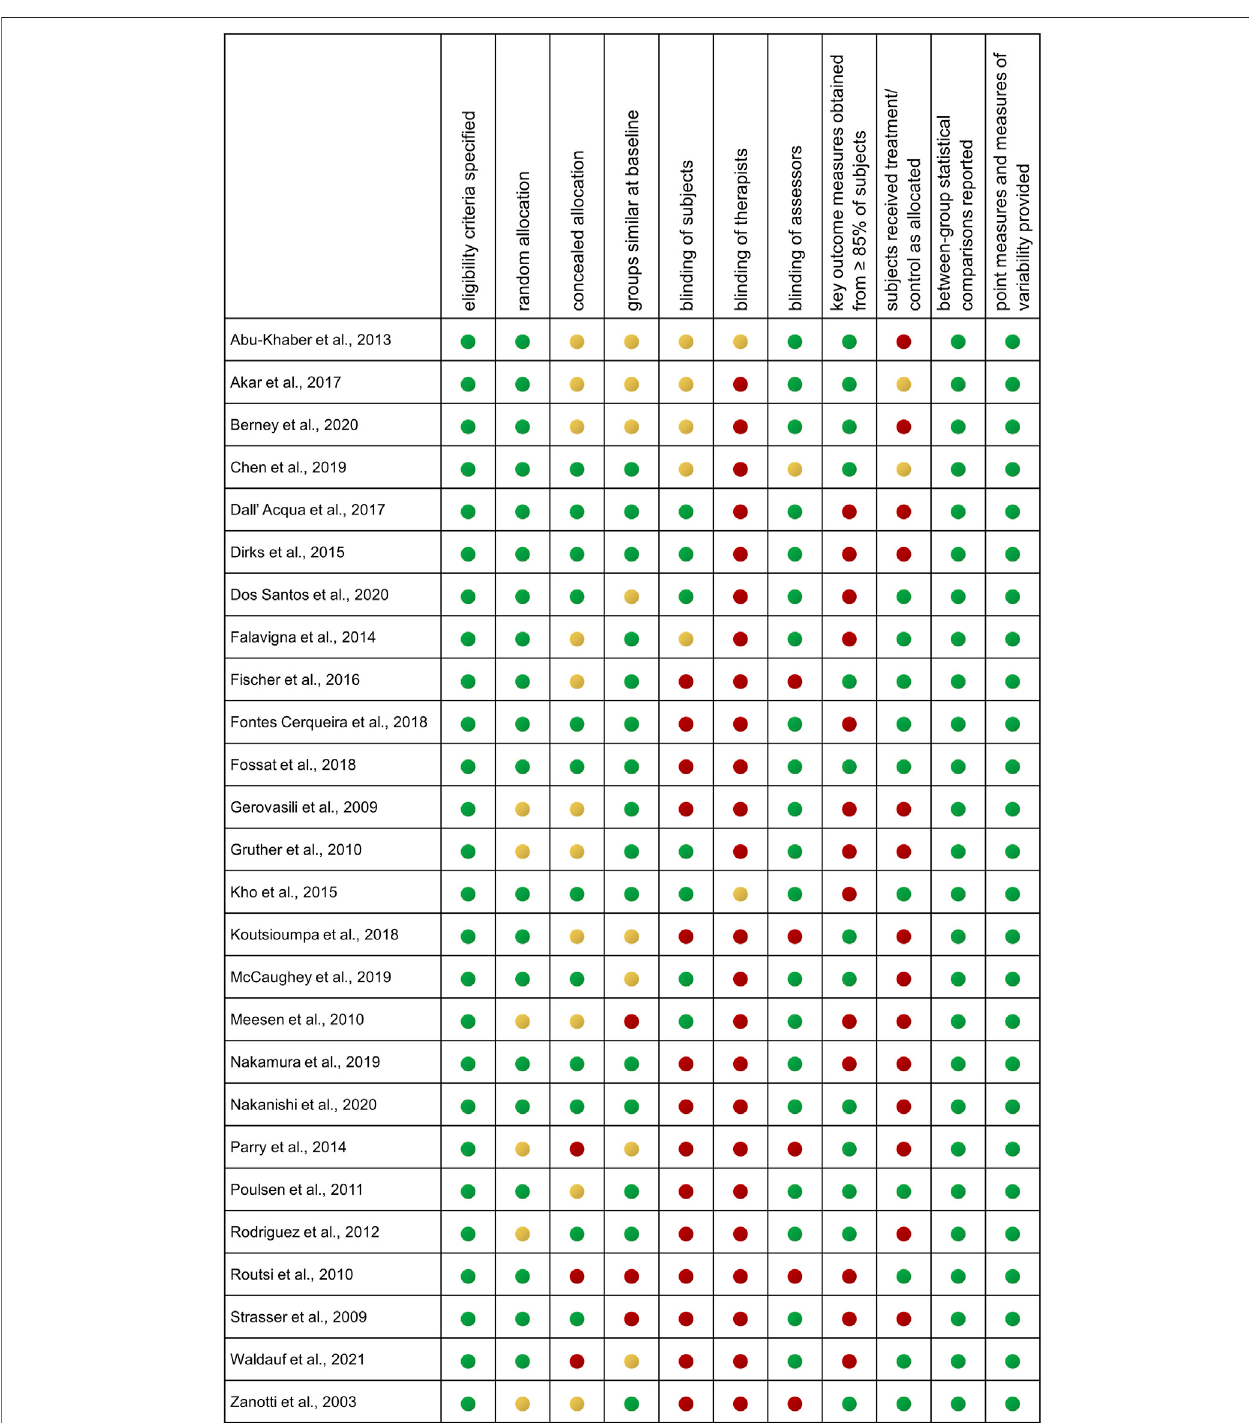
FIGURE 2 | Risk of bias assessment by PEDro scale for individual studies. Authors ’ judgement on the methodological quality of each included study assessed by the 11-item PEDro scale. Results are shown for each individual study. Green indicates low risk of bias, yellow indicates unclear risk of bias, and red indicates high risk of